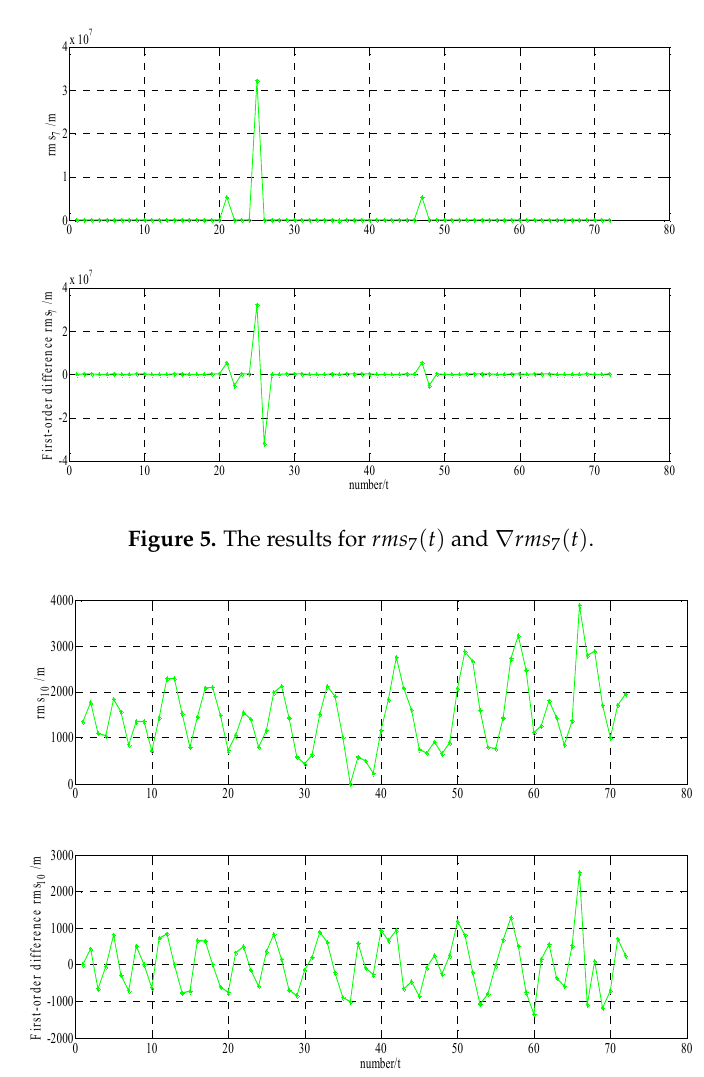
( ) rms t . ( ) rms t . ( ) rms t . 10 10 10